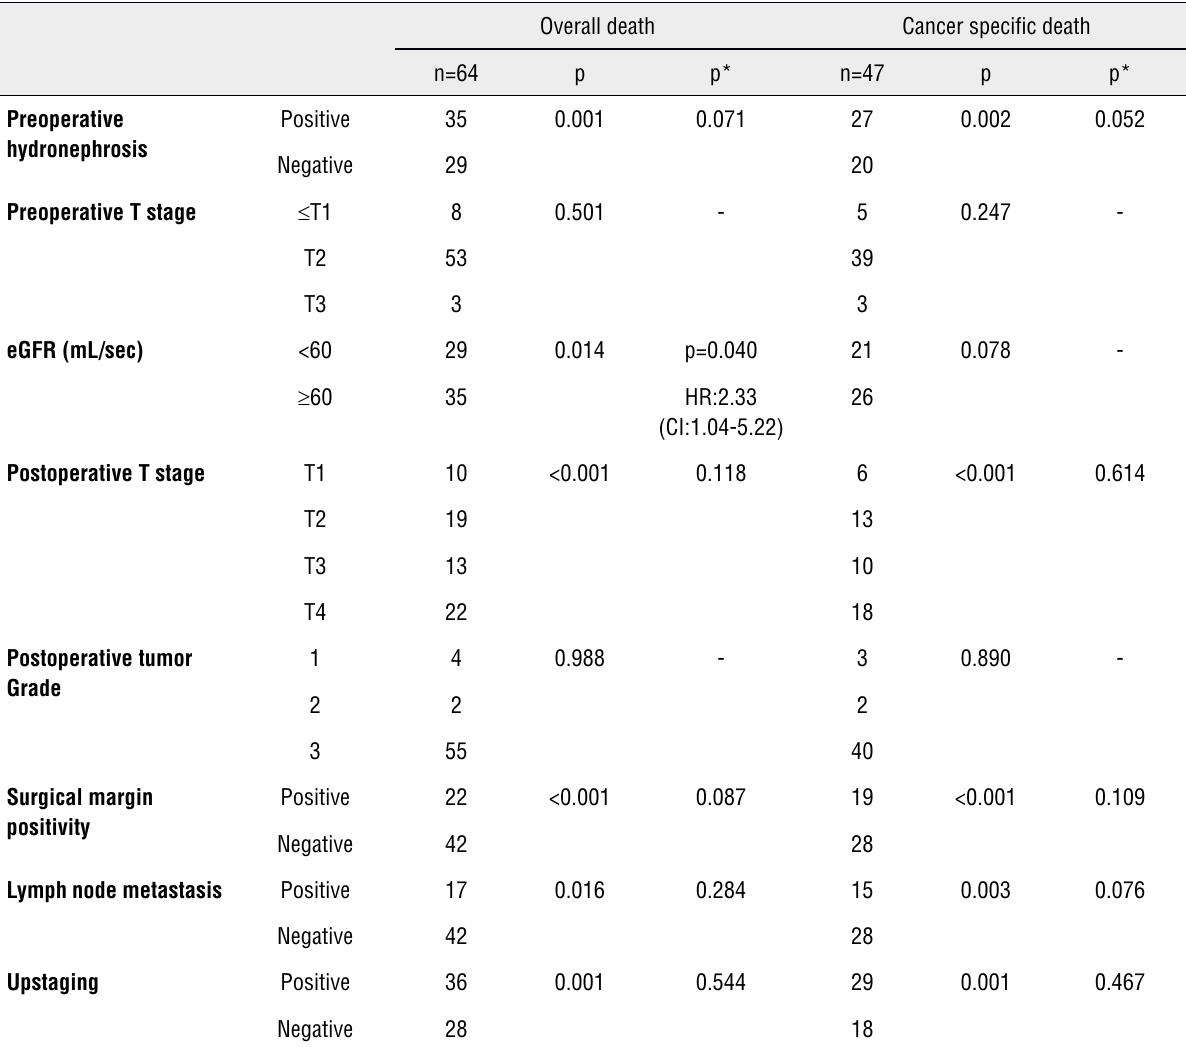
Table 4 - Univariate and multivariate analysis of the factors affecting on overall and cancer specific